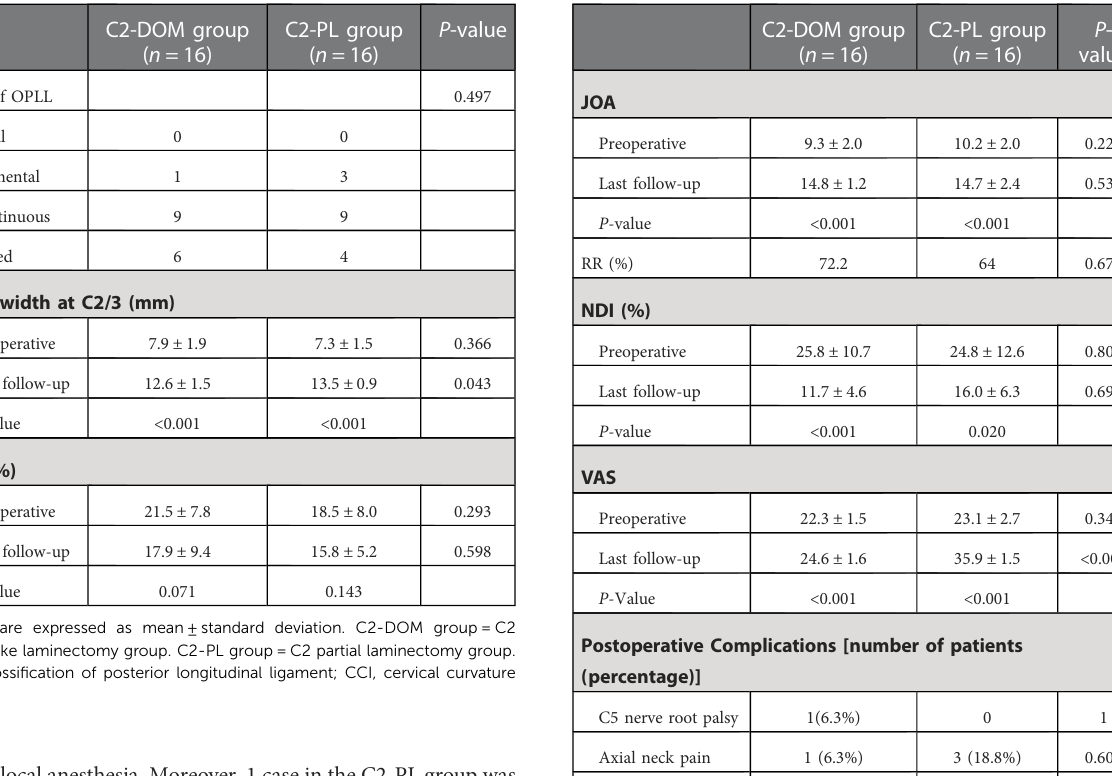
TABLE 2 Comparison of radiological measurement between C2-DOM group and C2-PL group.